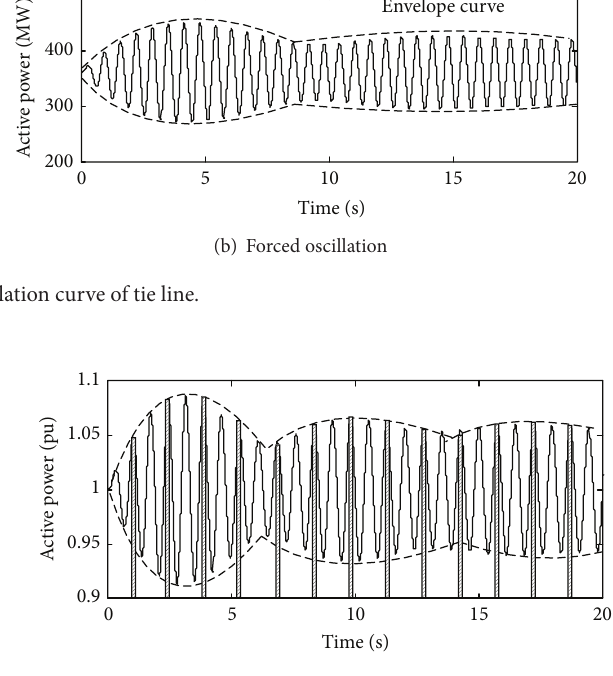
Figure 2: Extraction of the elements in the feature